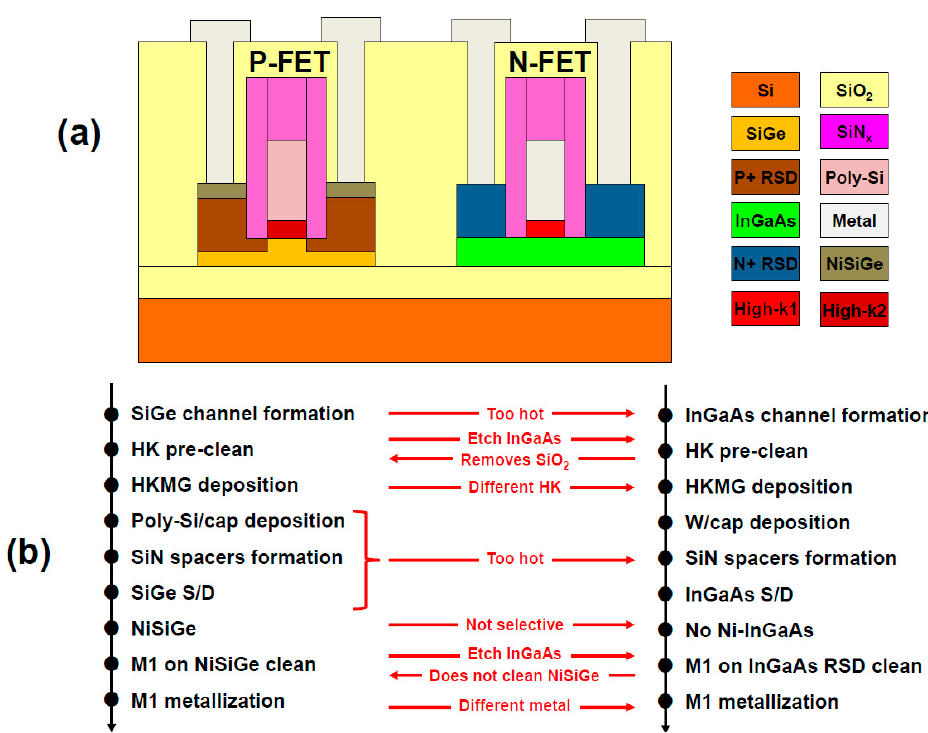
Figure 21. ( a ) Schematic of devices cross section and ( b ) process flow of 2D hybrid InGaAs/SiGe CMOS